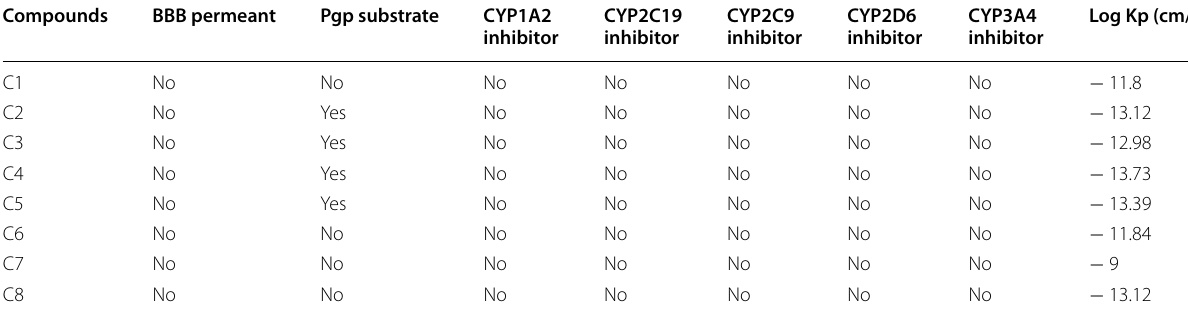
Table 5 Predicted pharmacokinetic properties of test compounds Compounds